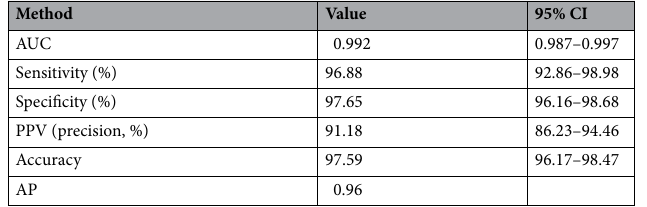
Table 2. Model performance on test datasets for classifying LTP. LTP, local tumor progression; CI, confidence interval; AUC, area under receiver operating characteristic curve; PPV, positive predictive value; AP, average